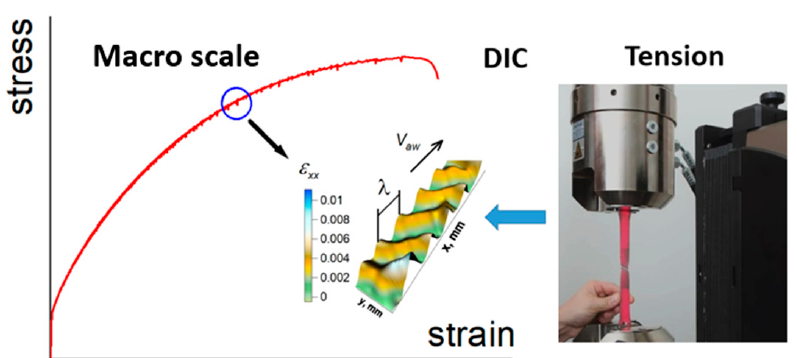
Figure 1. A schematic illustrating the length scale of the current study. Tensile test data are analyzed via digital image correlation (DIC) method at the macro scale level. Here, ε xx is the local elongation; x and y are the specimen length and width, respectively; λ is the nucleus spacing (the autowave length); V aw is the autowave propagation rate.